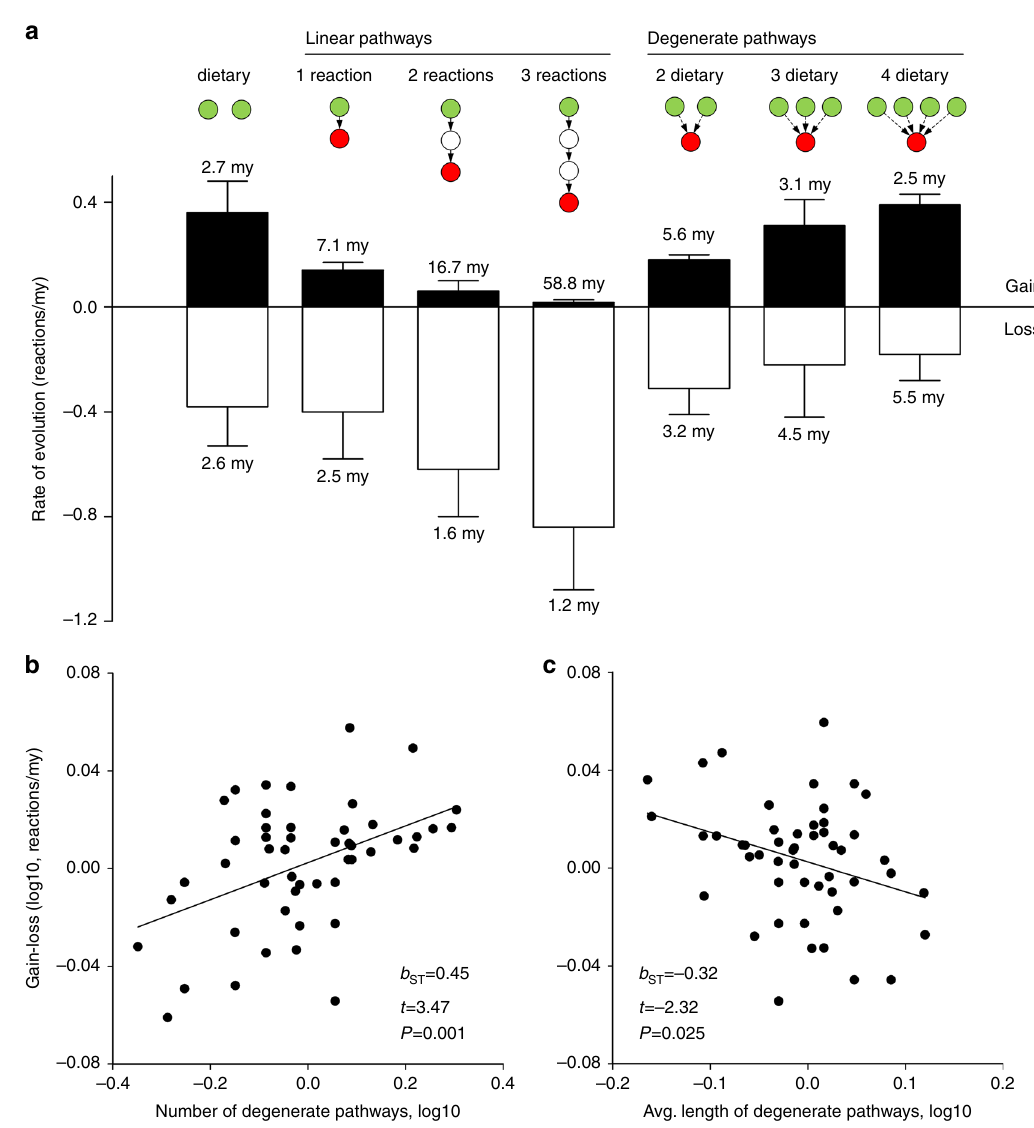
Fig. 3 Metabolic degeneracy sustains evolution of avian carotenoid networks. a Node occupancy rate (gains vs losses of nodes, in millions of years [my] ± 1 s.e.m.) in relation to distance (in reactions) from dietary inputs in linear (left group) and degenerate (right group) pathways. Average frequency of a loss of a dietary carotenoid (leftmost bar) sets the lowest limit for elongation of enzymatic pathways — sustained elongation is only possible when a new derived node is occupied at higher rate. Only degenerate pathways supported by >2 dietary carotenoids enable sustained growth of network. Under all other scenarios losses dominate, leading to network shrinkage or stasis. b , c Derived compounds closer to dietary carotenoids and those sustained by more paths are occupied more frequently in avian evolution — they are encountered faster and take longer to lose. Partial regression plots of a likelihood of gain minus the likelihood of a loss of a node regressed on b the number of degenerate pathways reaching this node, and c the average length of these pathways (Supplementary Data